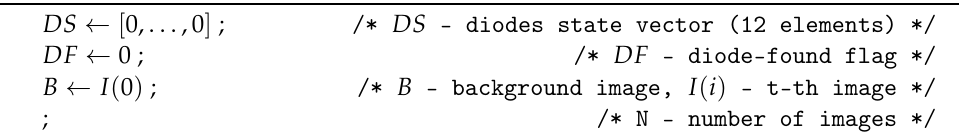
Algorithm 1: Post-processing algorithm for extraction of final image